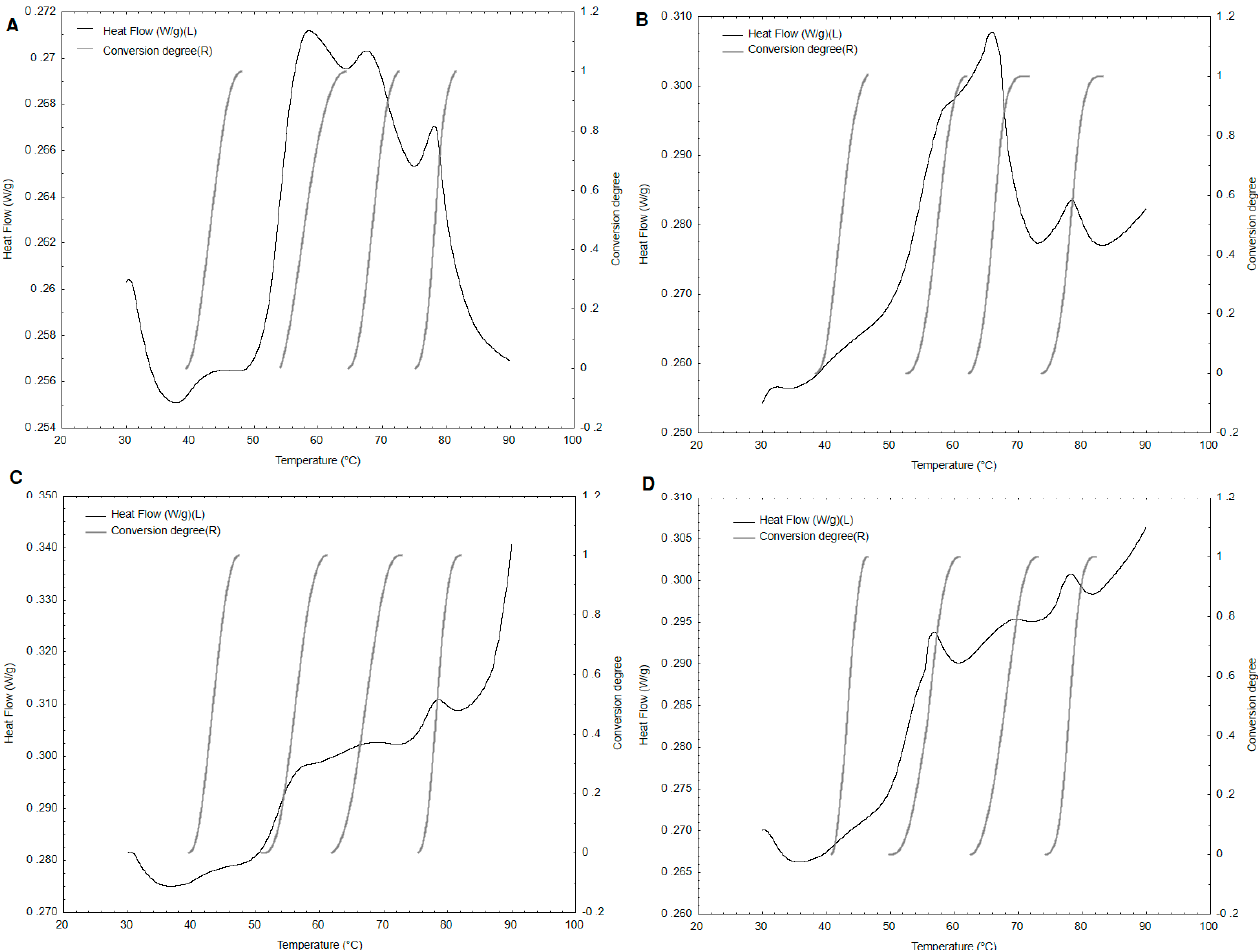
Figure 1. Conversion degrees calculated for consecutive stages from the differential scanning calorimetry (DSC) of Baltic herring ( n = 4, consecutive samples ( A – D